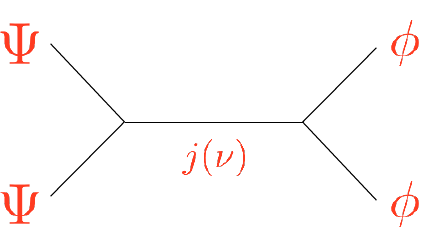
Figure 3 . In the Regge limit, the connected four-point function h (cid:9) (cid:30)(cid:30) (cid:9) i is dominated by Reggeon exchange in the (cid:9)(cid:9) ! (cid:30)(cid:30) channel. Unitarity bounds the three-point